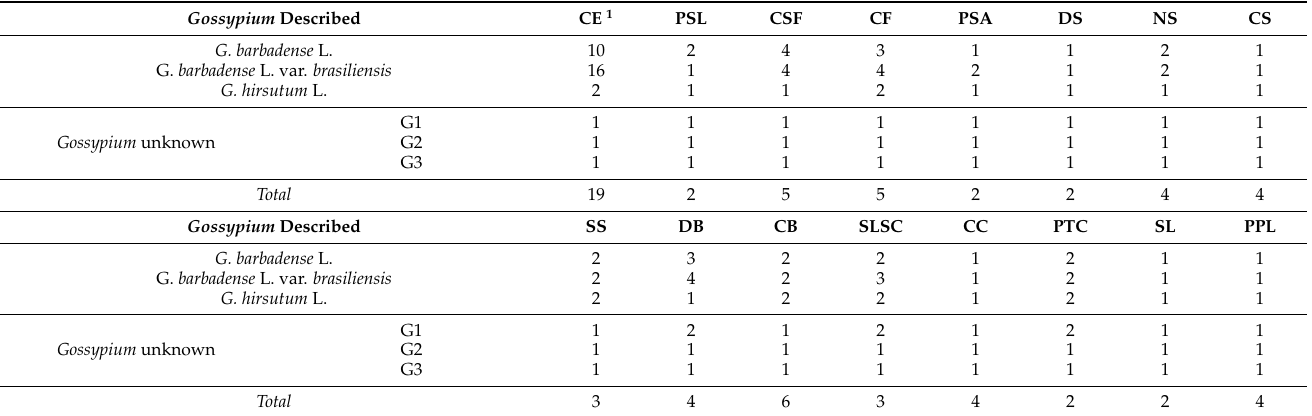
Table 4. Distribution of the number of classes when considering 16 qualitative descriptors obtained when characterizing species of Gossypium spp., collected in the province of La Convenci ó n, in the districts of Echatari and Megantoni, Cusco-Peru.